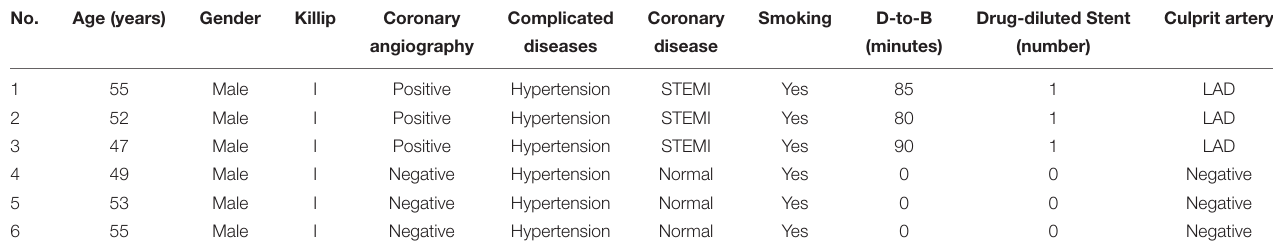
TABLE 1 | The clinical data of the six personals.